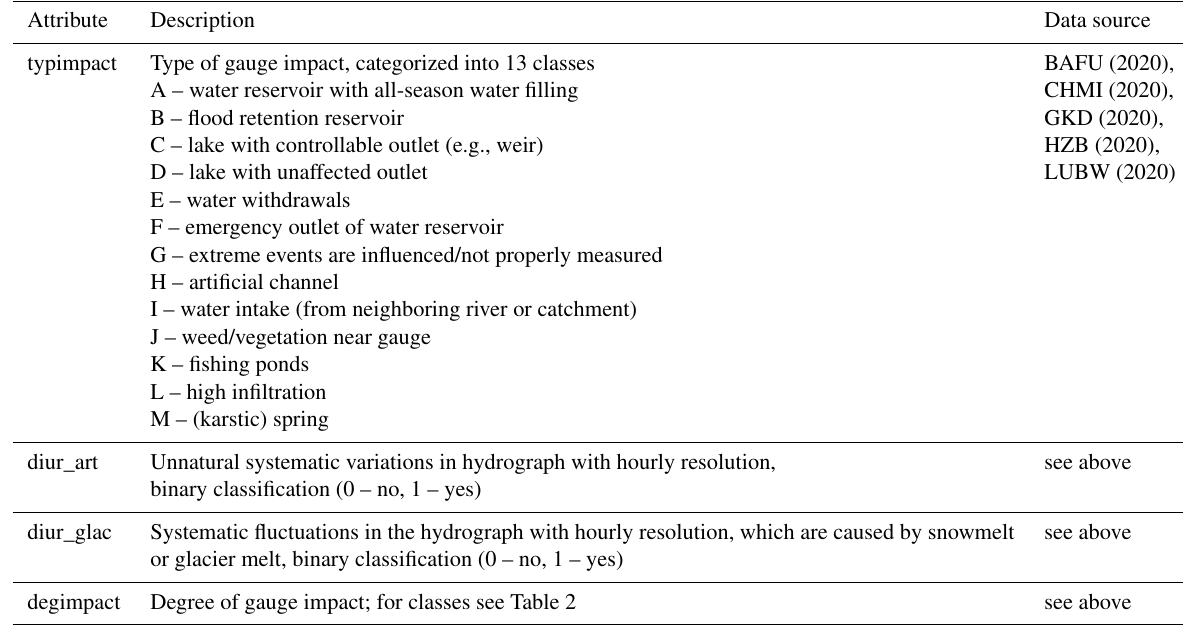
Table 2. Criteria for the different degrees of gauge impact. degimpact